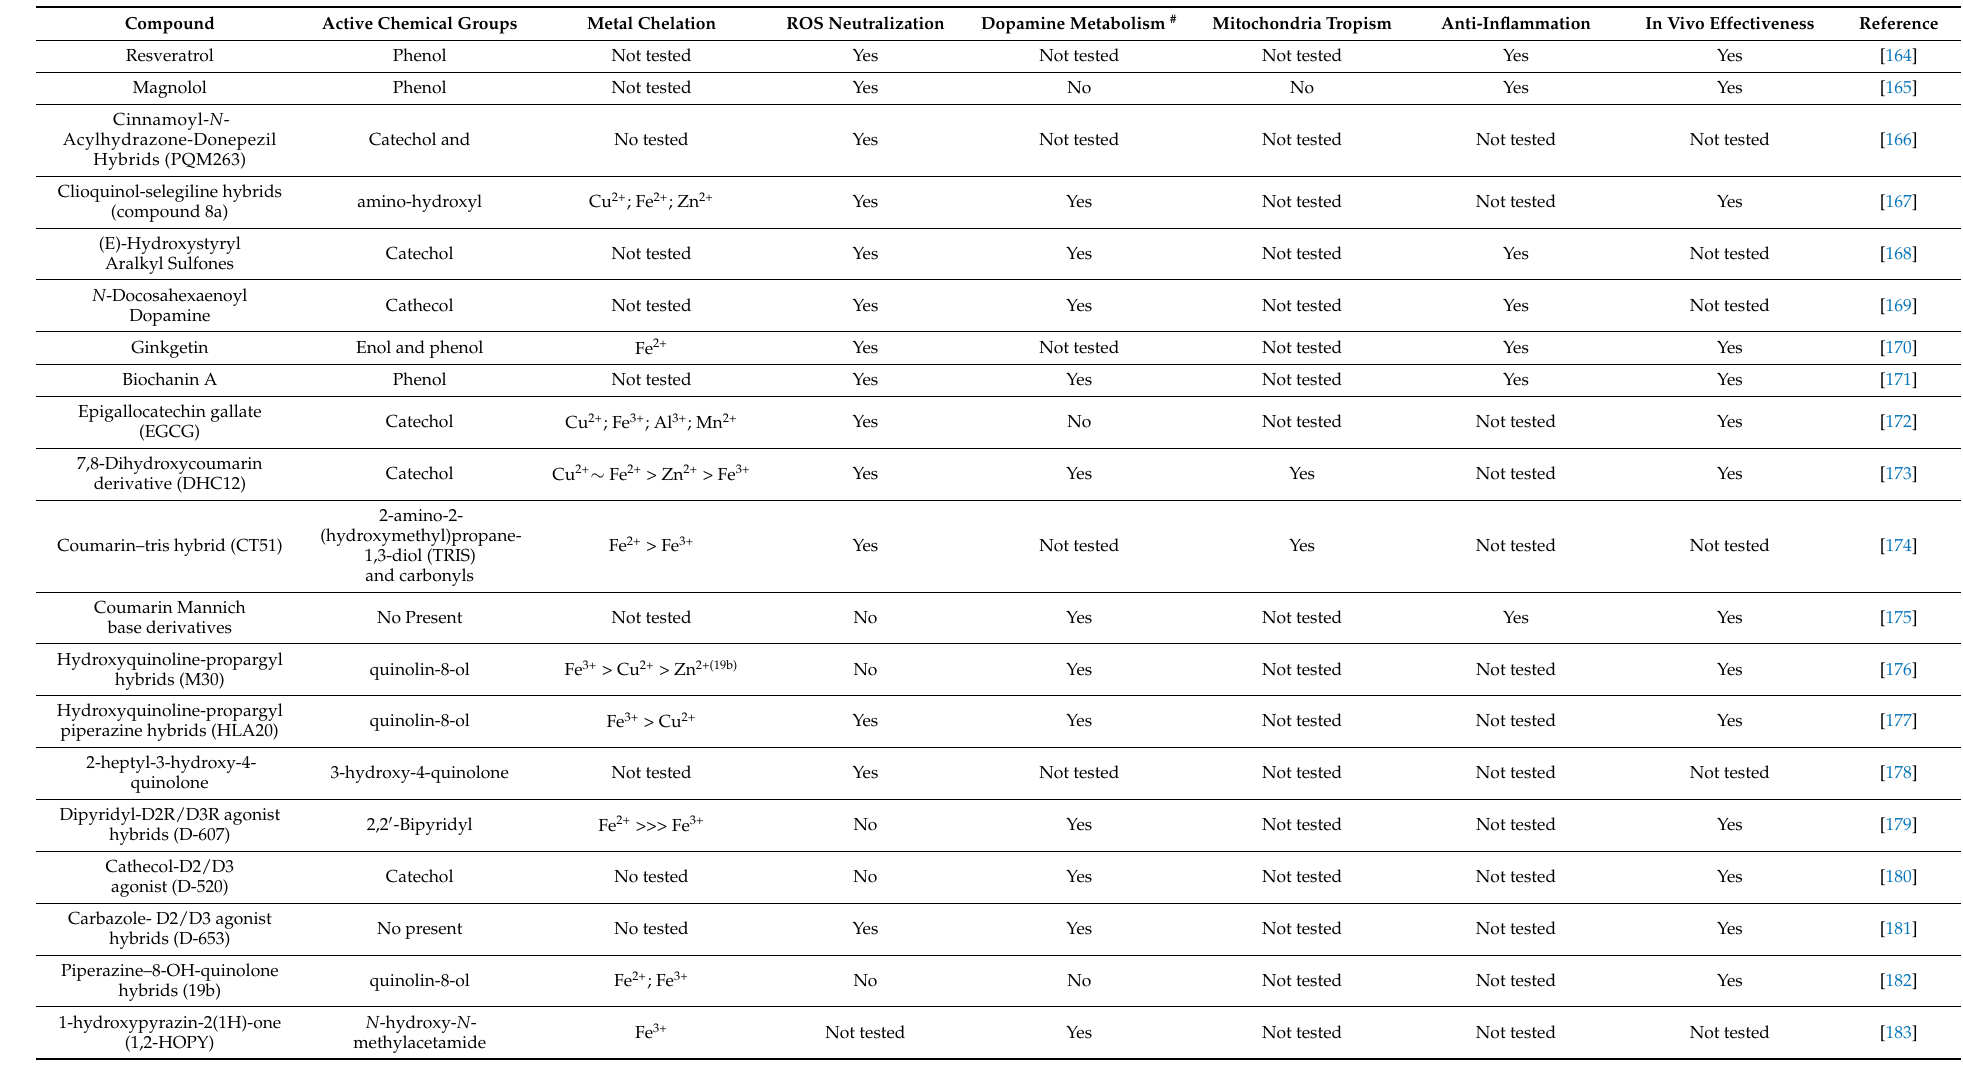
Table 1. Biological properties of multifunctional agents that could be used for the treatment of